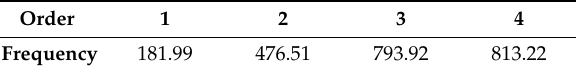
Table 2. The first four natural frequencies/Hz.